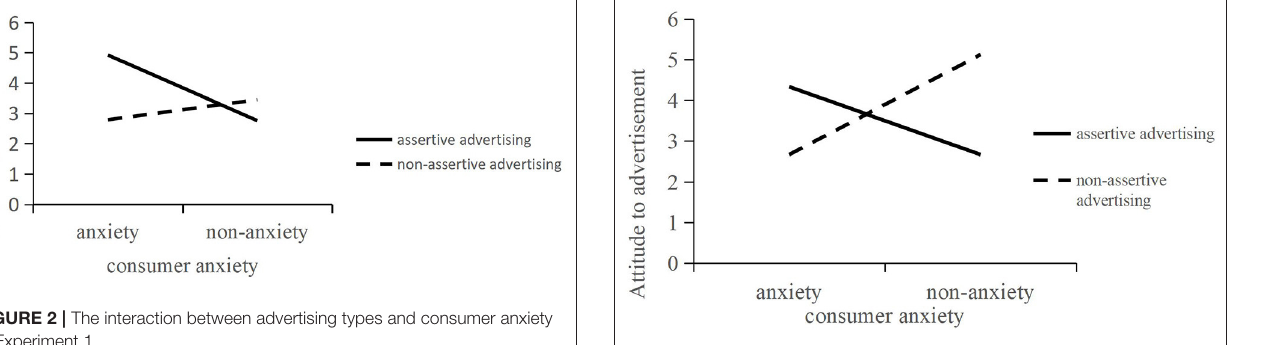
information such as their age and gender. The subjects were rewarded with a small gift after completing all the items.